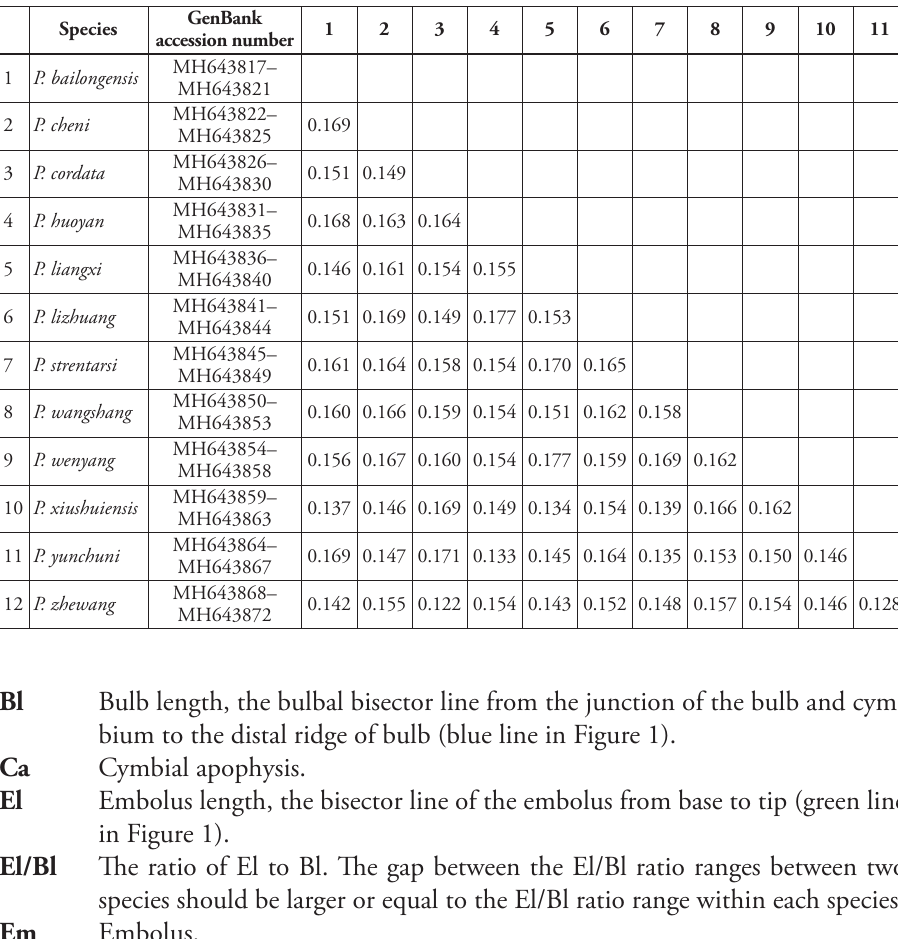
Table 1. GenBank accession numbers and mean inter-specific uncorrected p-distances of species in the P. bailongensis species group from COI